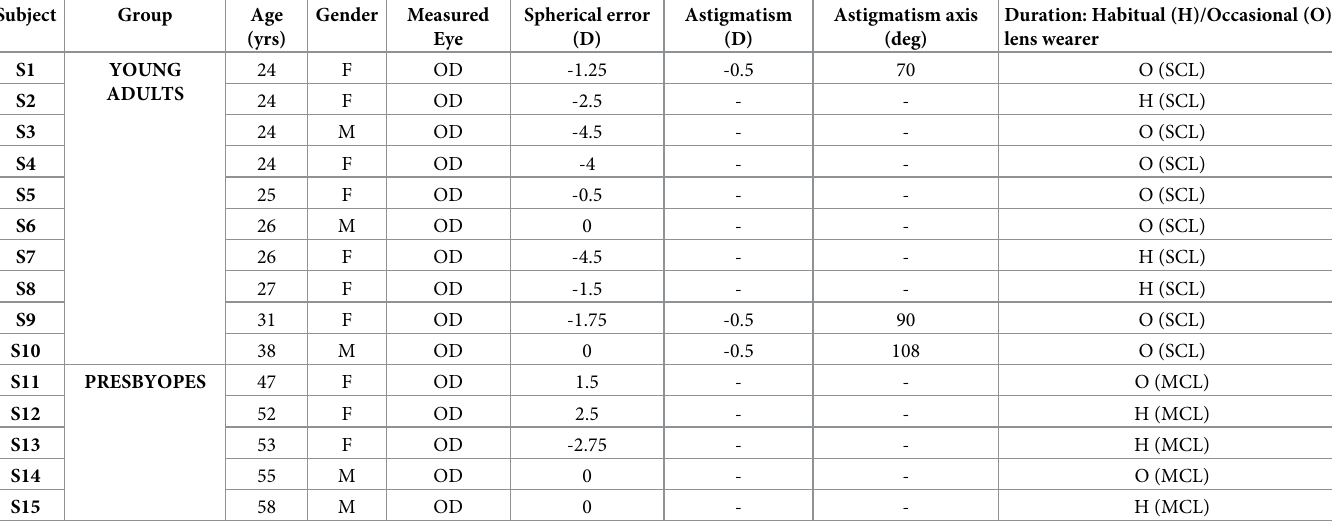
Table 1. Individual refractive profile of the subjects of the two groups (young adults and presbyopes).